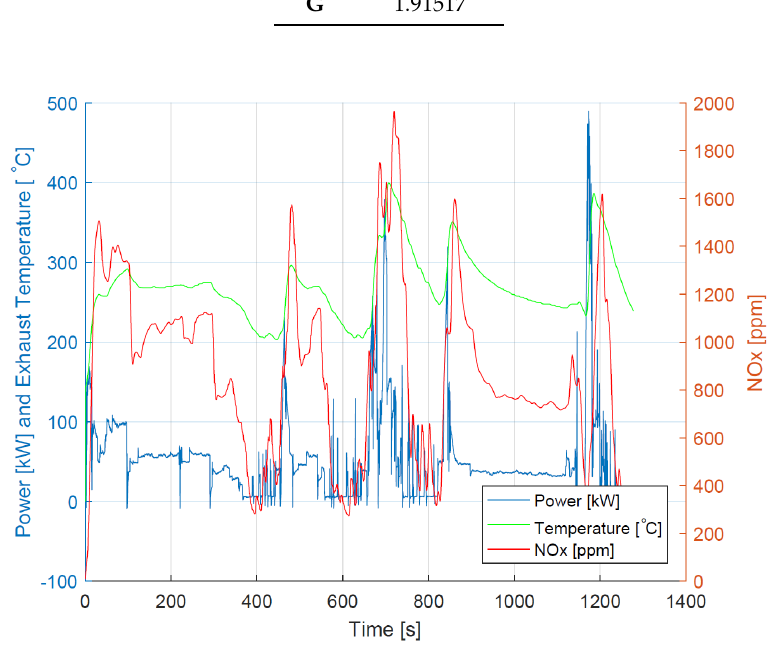
Figure 11. NOx emissions compared against power and temperature.